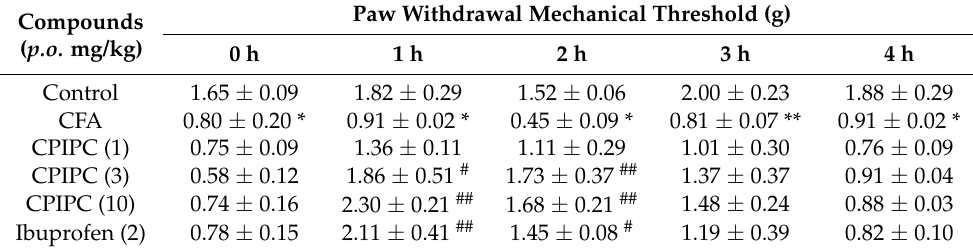
Data were expressed as the mean ± SEM ( n = 6–8). Statistical difference is indicated as * p < 0.05, ** p < 0.01 vs. control; # p < 0.05, ## p < 0.01 vs. CFA by two-way ANOVA and post hoc Bonferroni’s